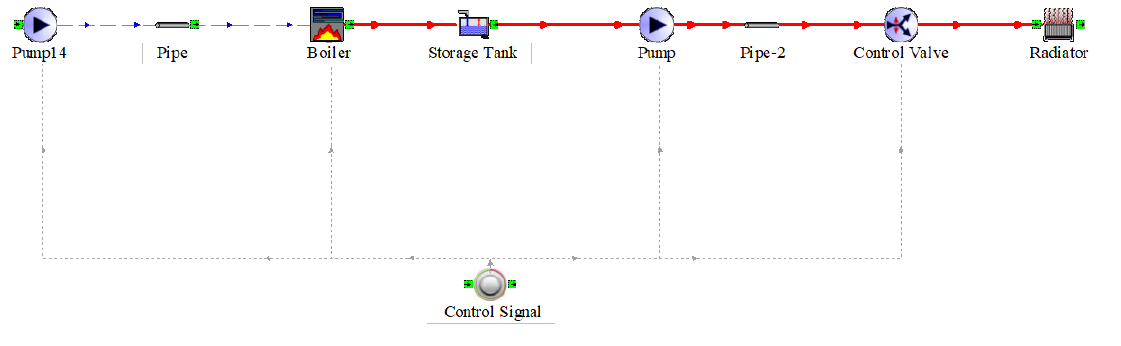
Figure 4. TRNSYS Simulation Model. Blue lines show cold streams, red shows hot streams and grey shows auxiliary streams (occupancy schedules, control signals etc.).